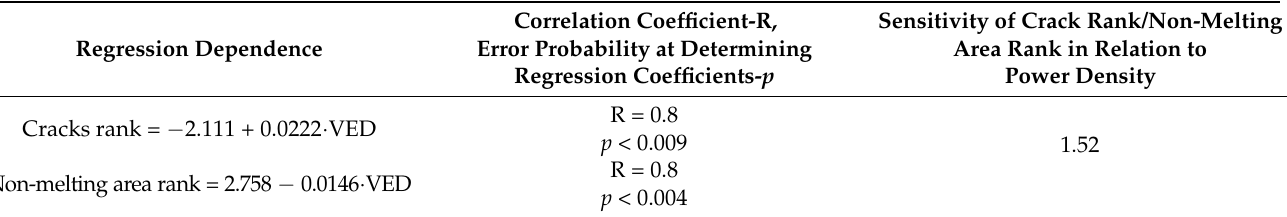
Figure 5. RSA Method for Determining the Area of Optimal Fe-6.5Si Fusion Modes. Table 4. Regression